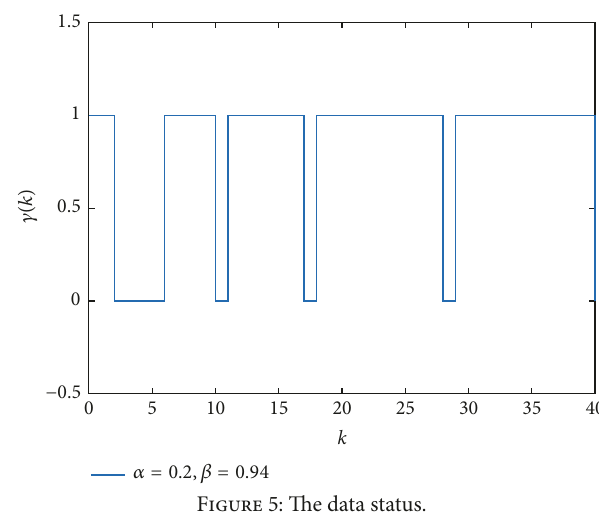
Figure 5: The data